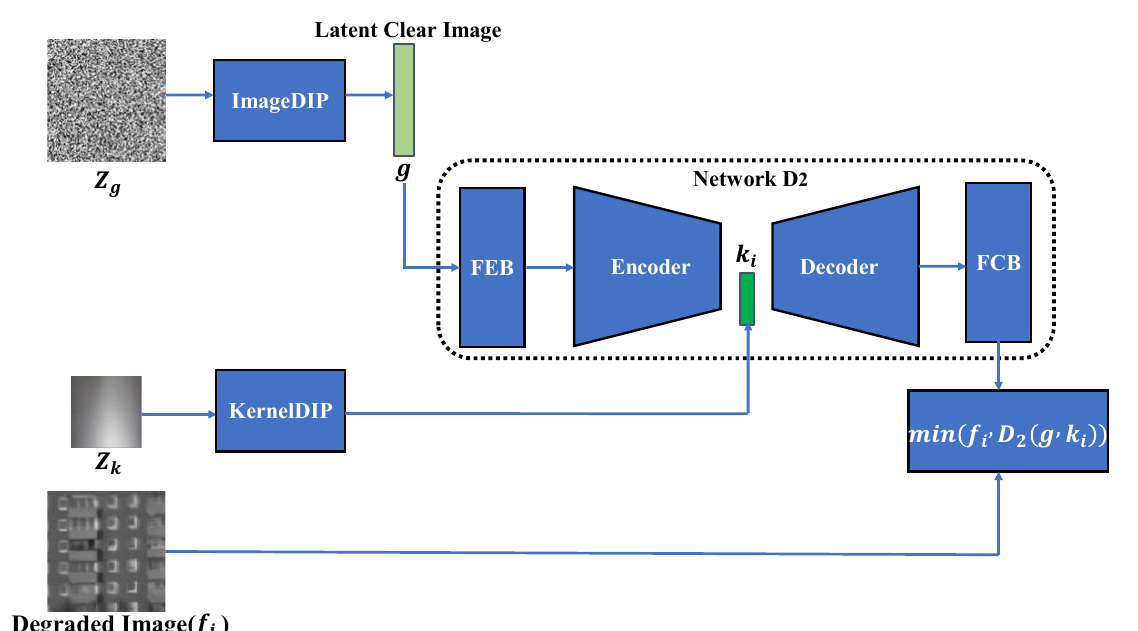
Figure 2. The overall architecture of the proposed DTL network (inference processing).